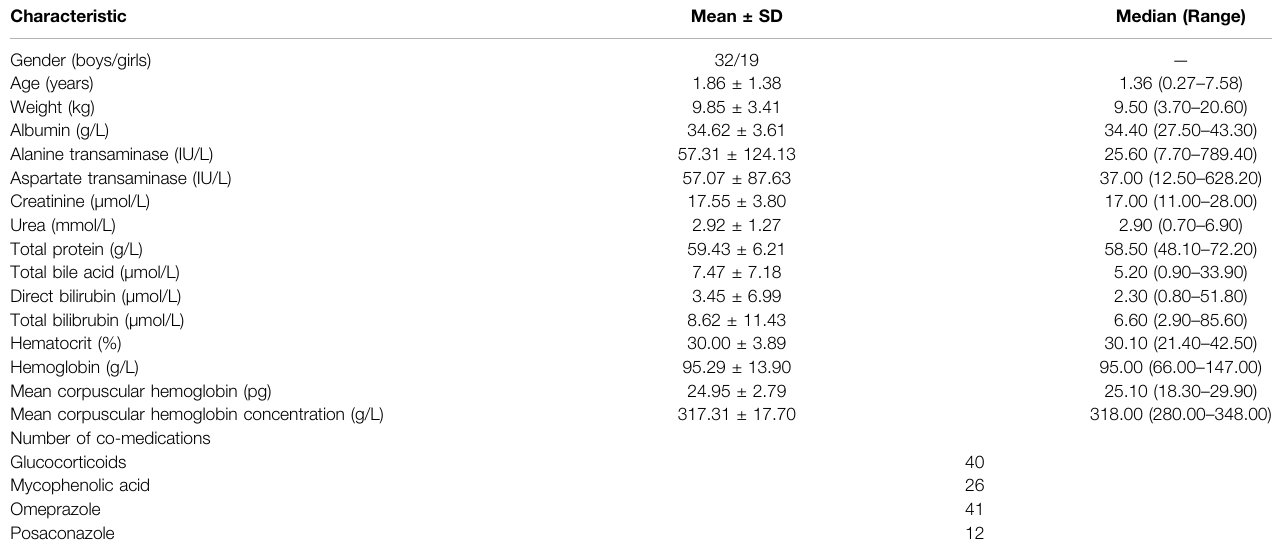
TABLE 1 | Demographic data of patients and drug combination ( n = 51).